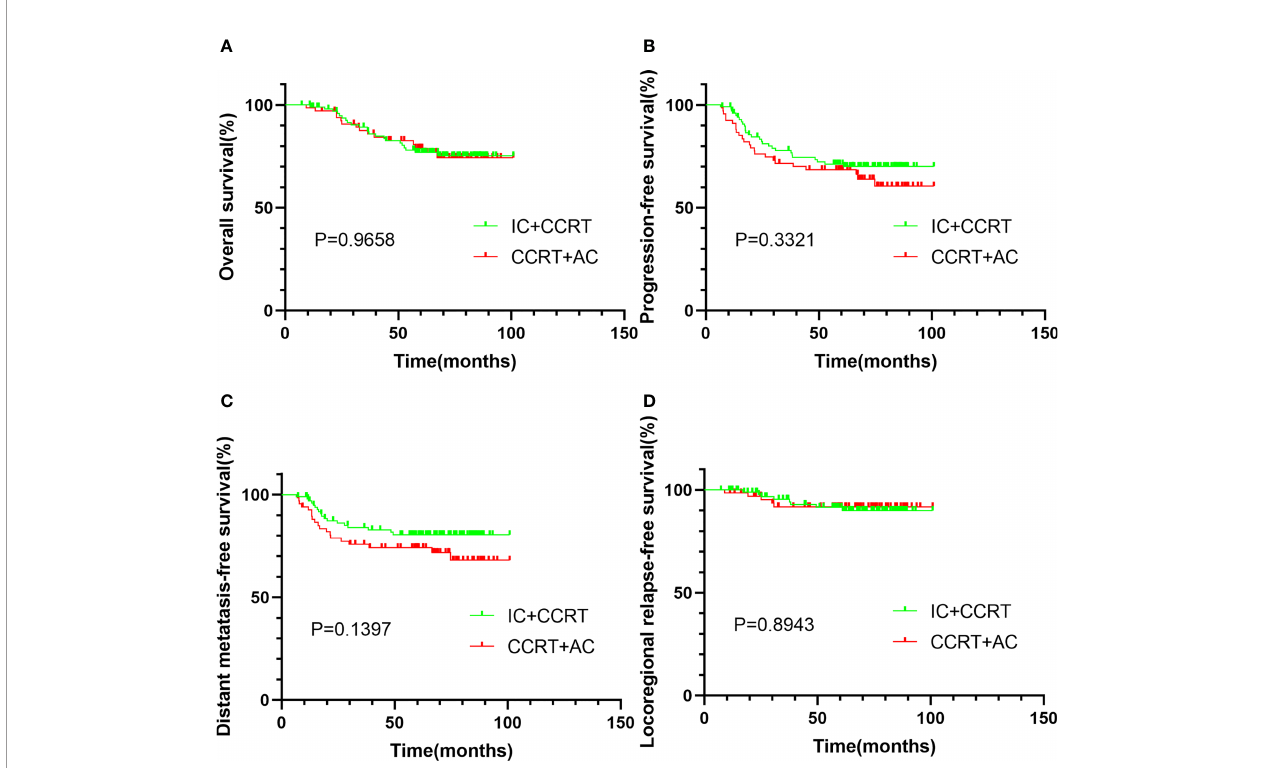
FIGURE 2 | Kaplan – Meier survival curves of OS (A) , PFS (B) , DMFS (C) , and LRRFS (D) for patients strati fi ed as IC + CCRT and CCRT + AC after PSM. OS, overall survival; PFS, progression-free survival; DMFS, distant metastasis-free survival; LRRFS, locoregional relapse-free survival; IC, induction chemotherapy; AC, adjuvant chemotherapy; CCRT, concurrent chemoradiotherapy; PSM, propensity score